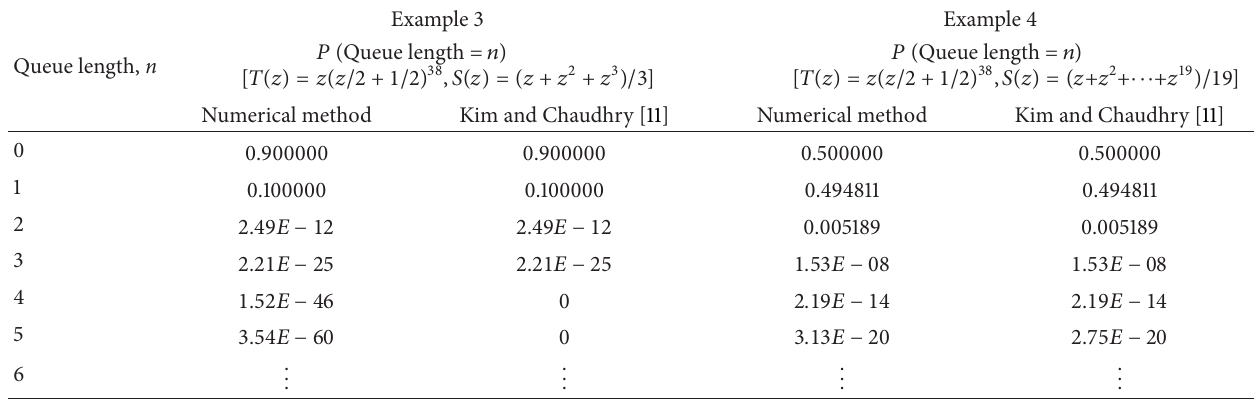
Table 6: Comparison of stationary queue length distributions computed using the proposed numerical method and that given in Kim and Chaudhry [11] ( Δ𝑡 = 1.0).